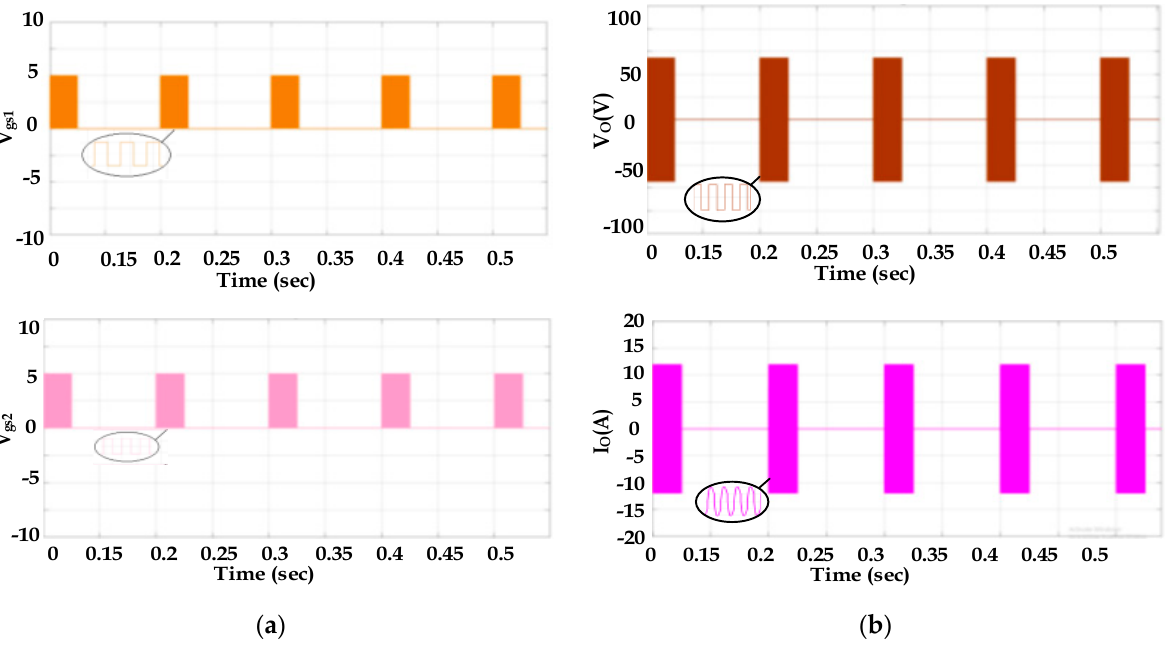
Figure 14. Simulation waveforms of Mode 4 with 25% PDM: ( a ) switching pulses and ( b ) output voltage and current.